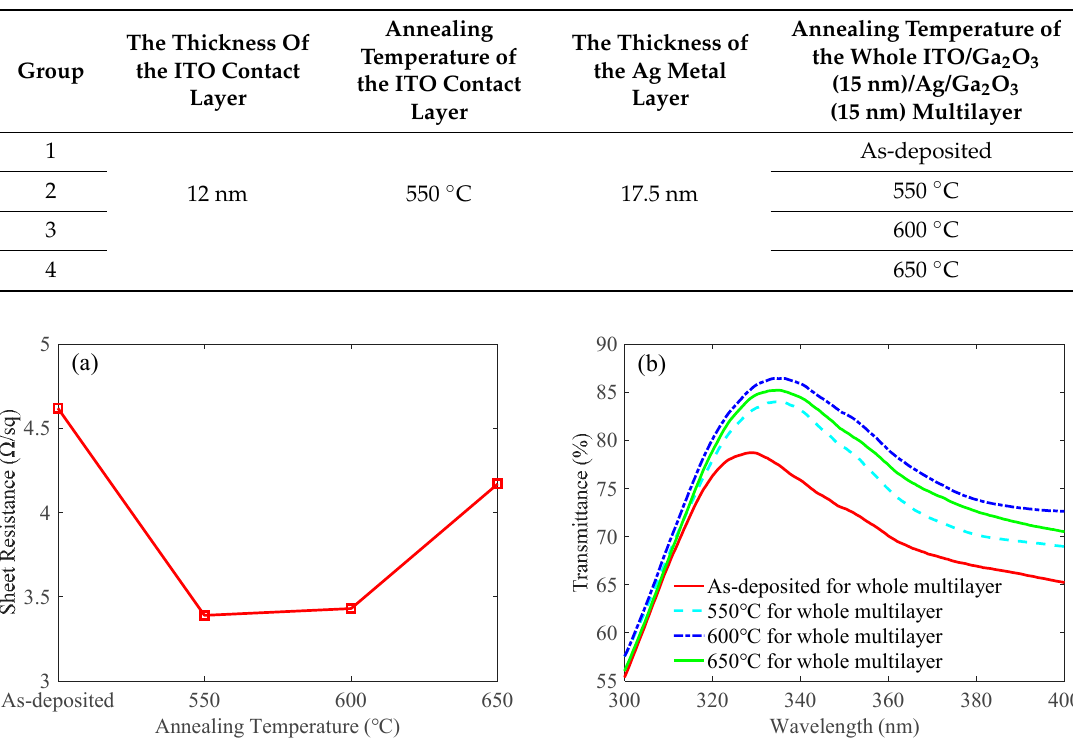
Table 3. The experimental design matrix for the optimal annealing temperature of the whole ITO/Ga 2 O 3 /Ag/Ga 2 O 3 multilayer.